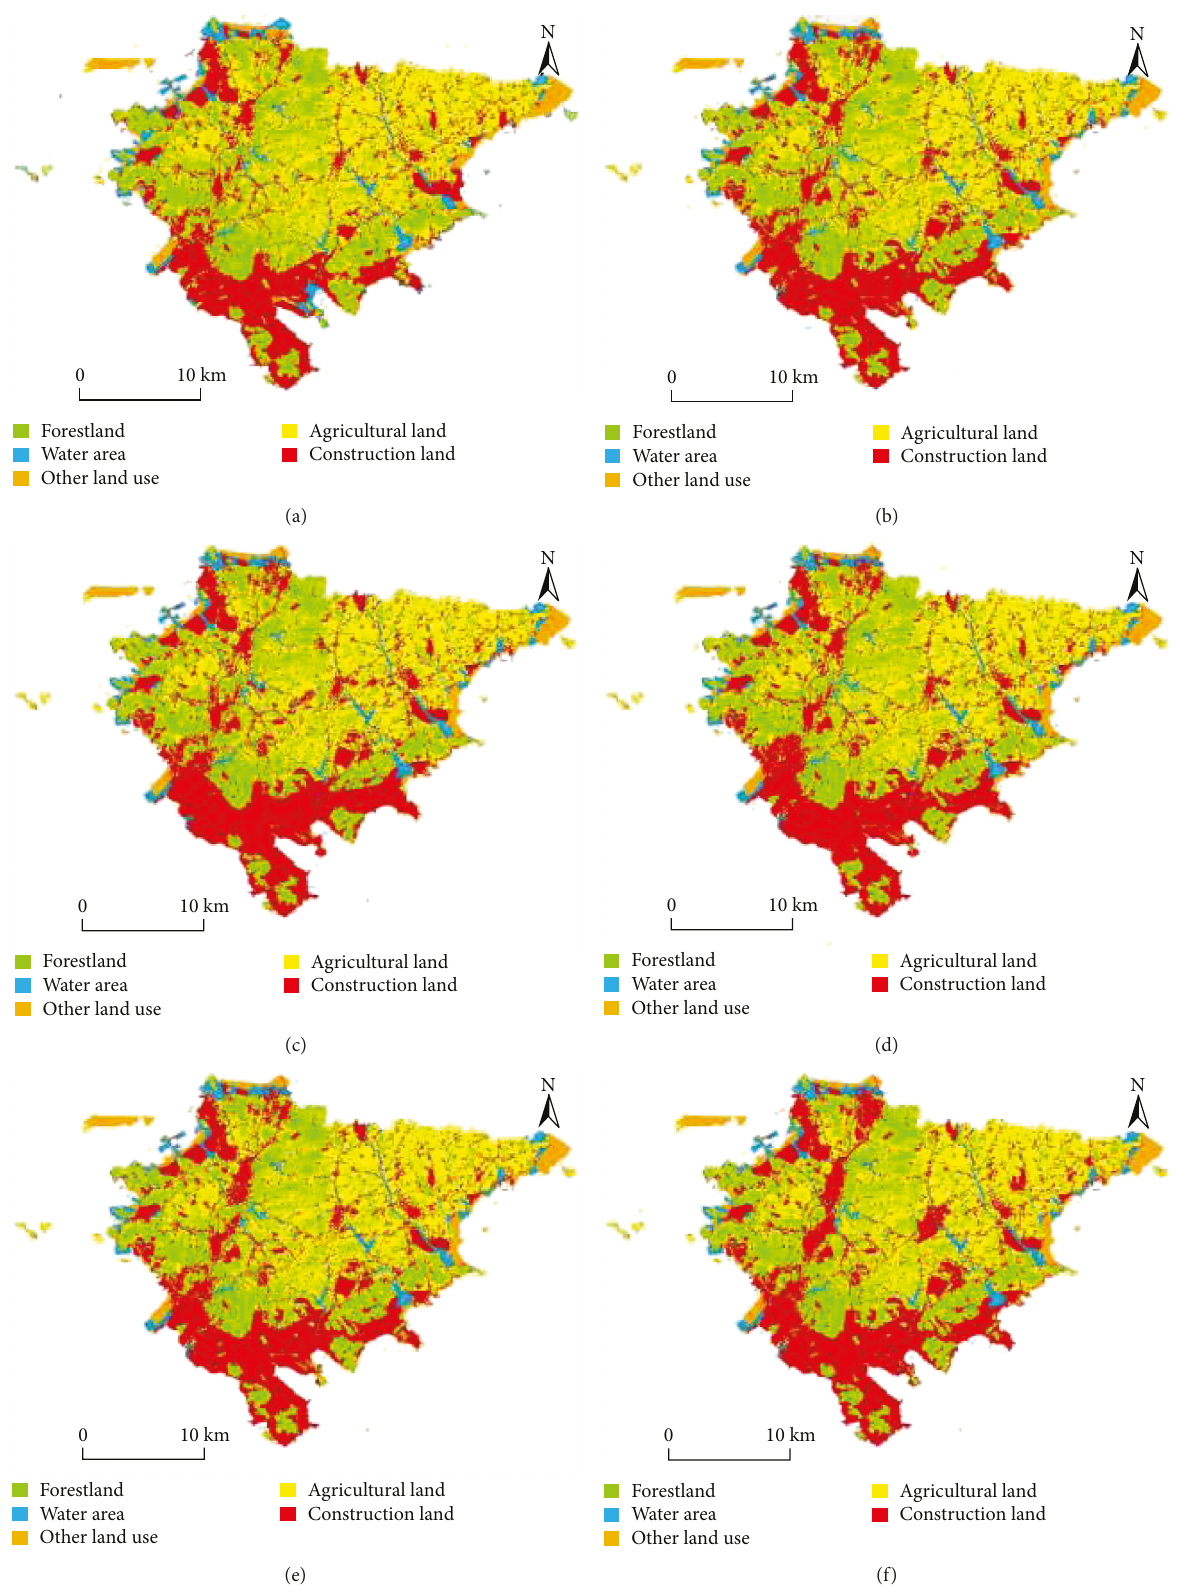
Figure 6: (a) Actual data of land use in 2015; (b) simulated data of land use in 2015; (c – f) land use simulation data under S1, S2, S3, and S4 scenarios, respectively, for Jinzhou District in